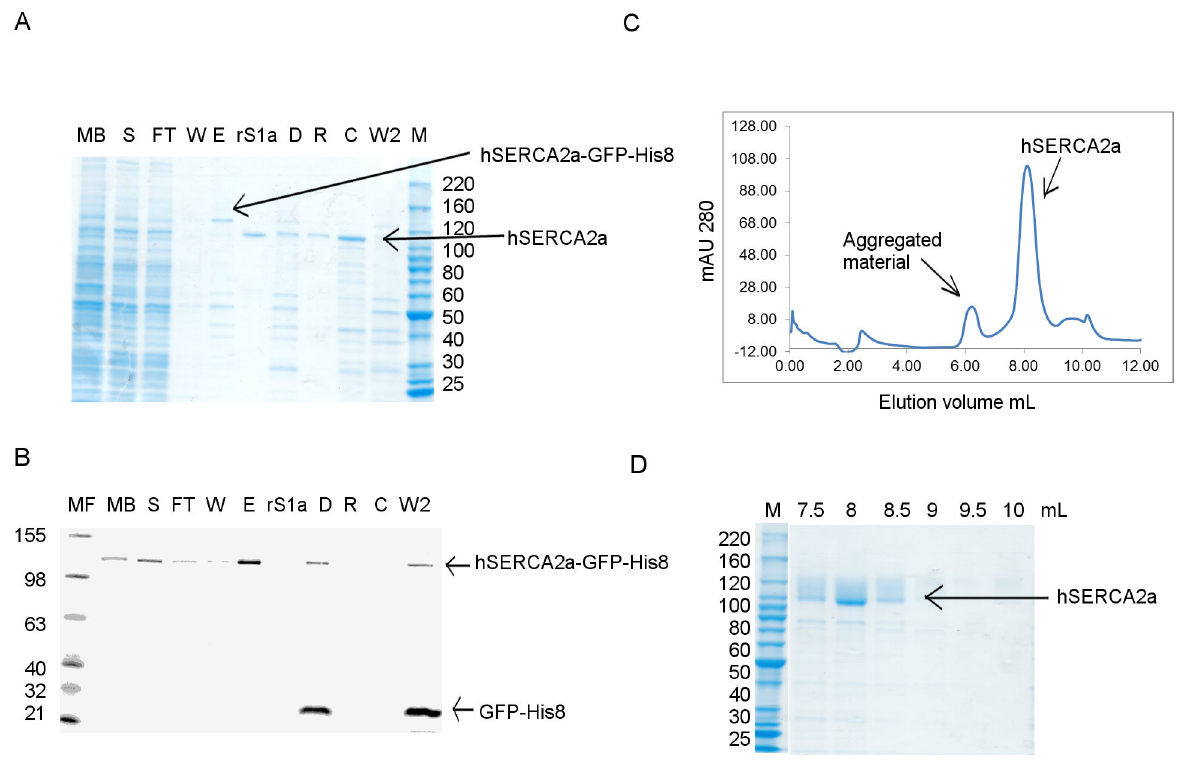
Figure 4. Talon resin affinity purification of h SERCA2a-GFP-His . Protein was obtained using minimal media. A . Coomassie 8 stained SDS-PAGE gel; B . In gel fluorescence 12% Tris-Glycine SDS-PAGE gel, MF- fluorescent protein ladder; MB- membranes fraction; S- solubilised fraction; FT- flow-through after binding to Talon resin; W- wash fraction; E- elution; D- sample after cleavage with TEV protease and dialysis; R- sample after Ni-NTA reverse binding; C- sample concentrated, before gel filtration; rS1a- rabbit SERCA1a at; C- fraction containing human SERCA2a concentrated before gel filtration; W2- eluted material from Ni-NTA His trap after reverse Ni-NTA purification; M- protein ladder. C . HPLC-SEC profile for h SERCA2a purified using Talon resin. Protein was concentrated with 100 kDa cut-off filter concentrator and DDM detergent was exchanged on gel filtration column with C E 12 8 detergent. D . Coomassie stained 4-12% Tris-Glycine SDS PAGE gel for SEC fractions obtained for purification of h SERCA2a using Talon super-flow resin.